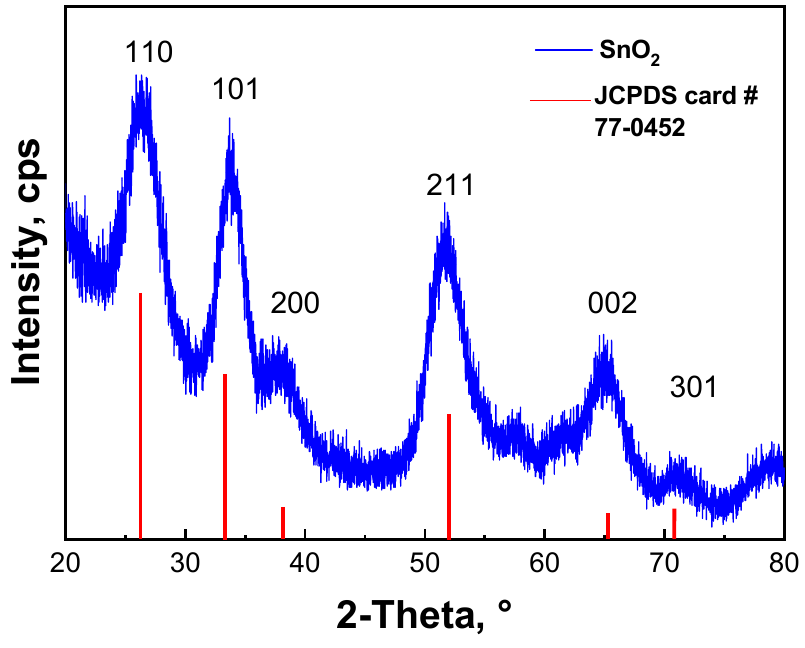
Figure 3. XRD pattern of as-prepared SnO 2 QDs.